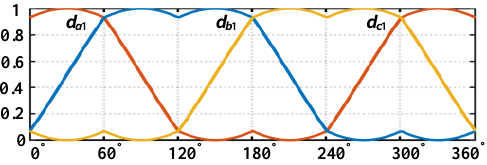
Figure 6. The duty cycle of SVPWM algorithm with the optimal dwell time of the